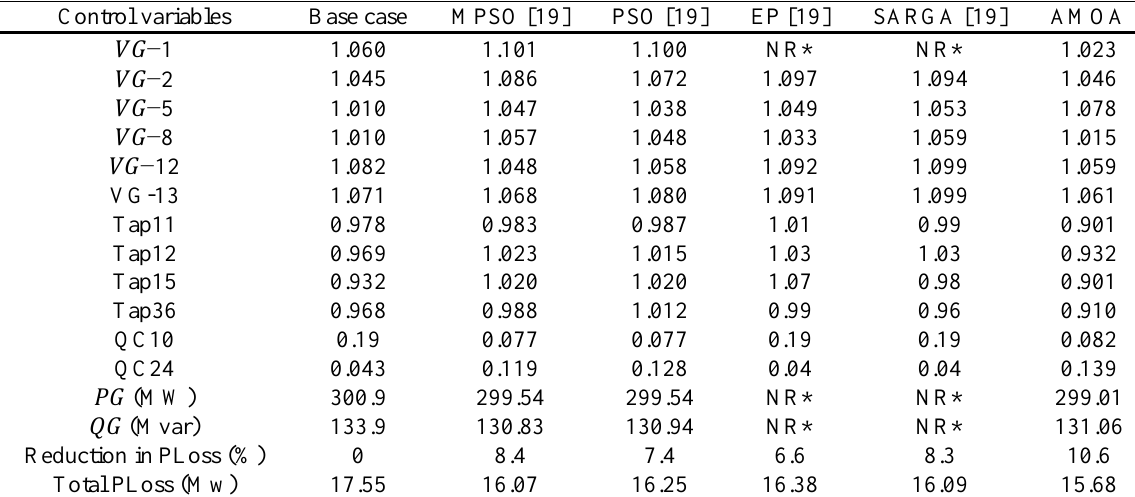
Table 6. Simulation results of IEEE −30 system.